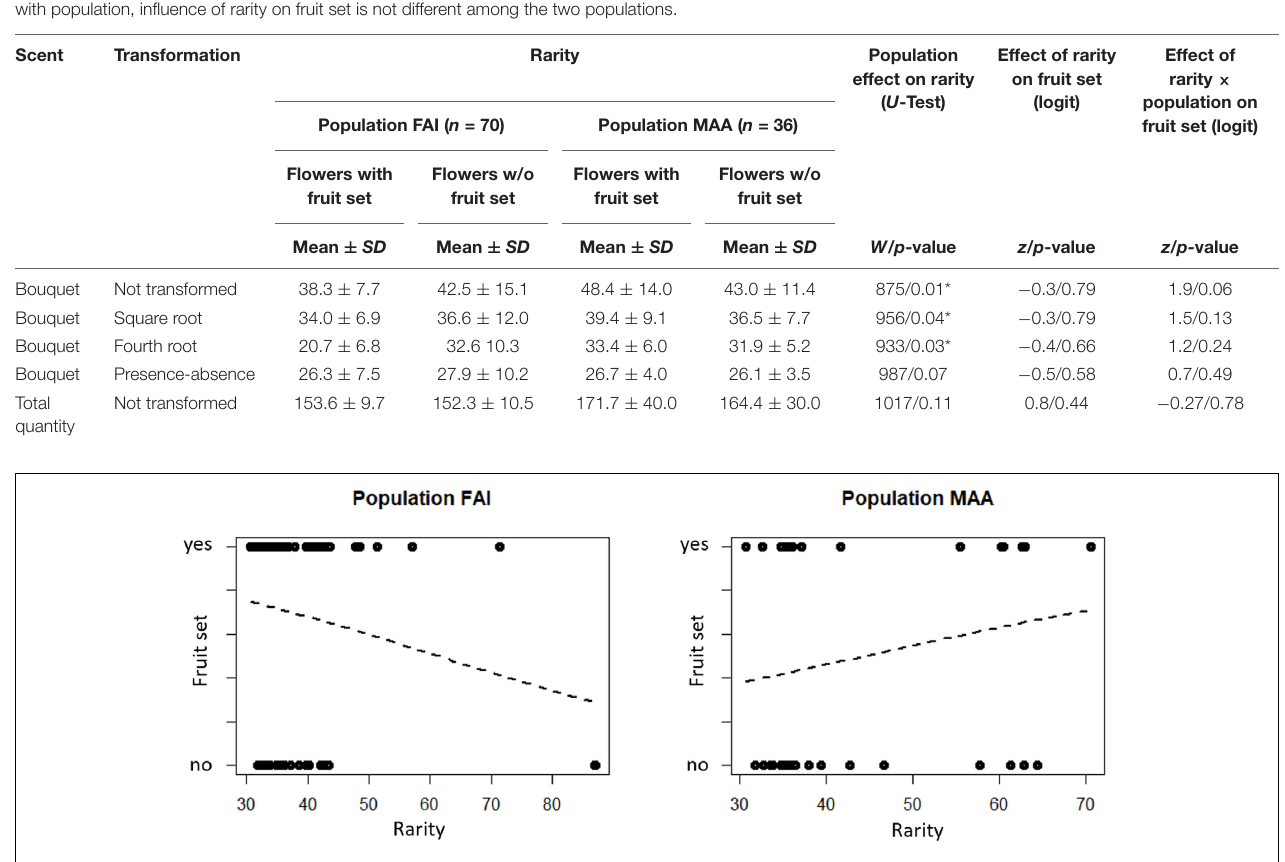
FIGURE 2 | Rarity of scent in flowers with and without fruit set of the two study populations FAI (Faistenau) and MAA (Maria Alm). Rarity values are the mean Bray-Curtis dissimilarities of a sample to all other samples in the population, based on relative amounts of the scent bouquets. Logistic regression results indicate that the rarity of the scent of a flower is not a significant predictors of whether a flower sets a fruit (see also Table 1 ).